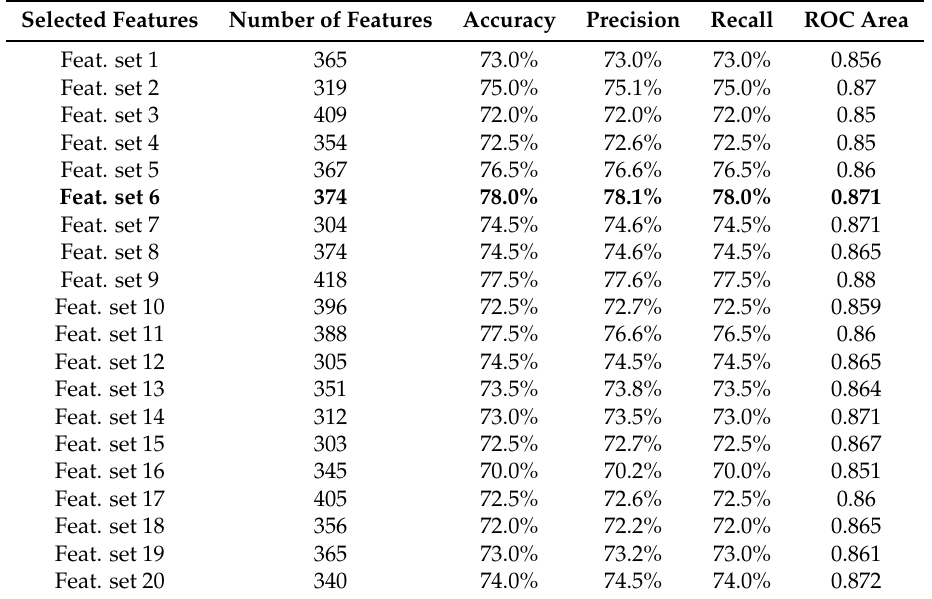
Table 8. Detection of benign or malignant using BGWO with fusion features of curvelet and wavelet. Selected